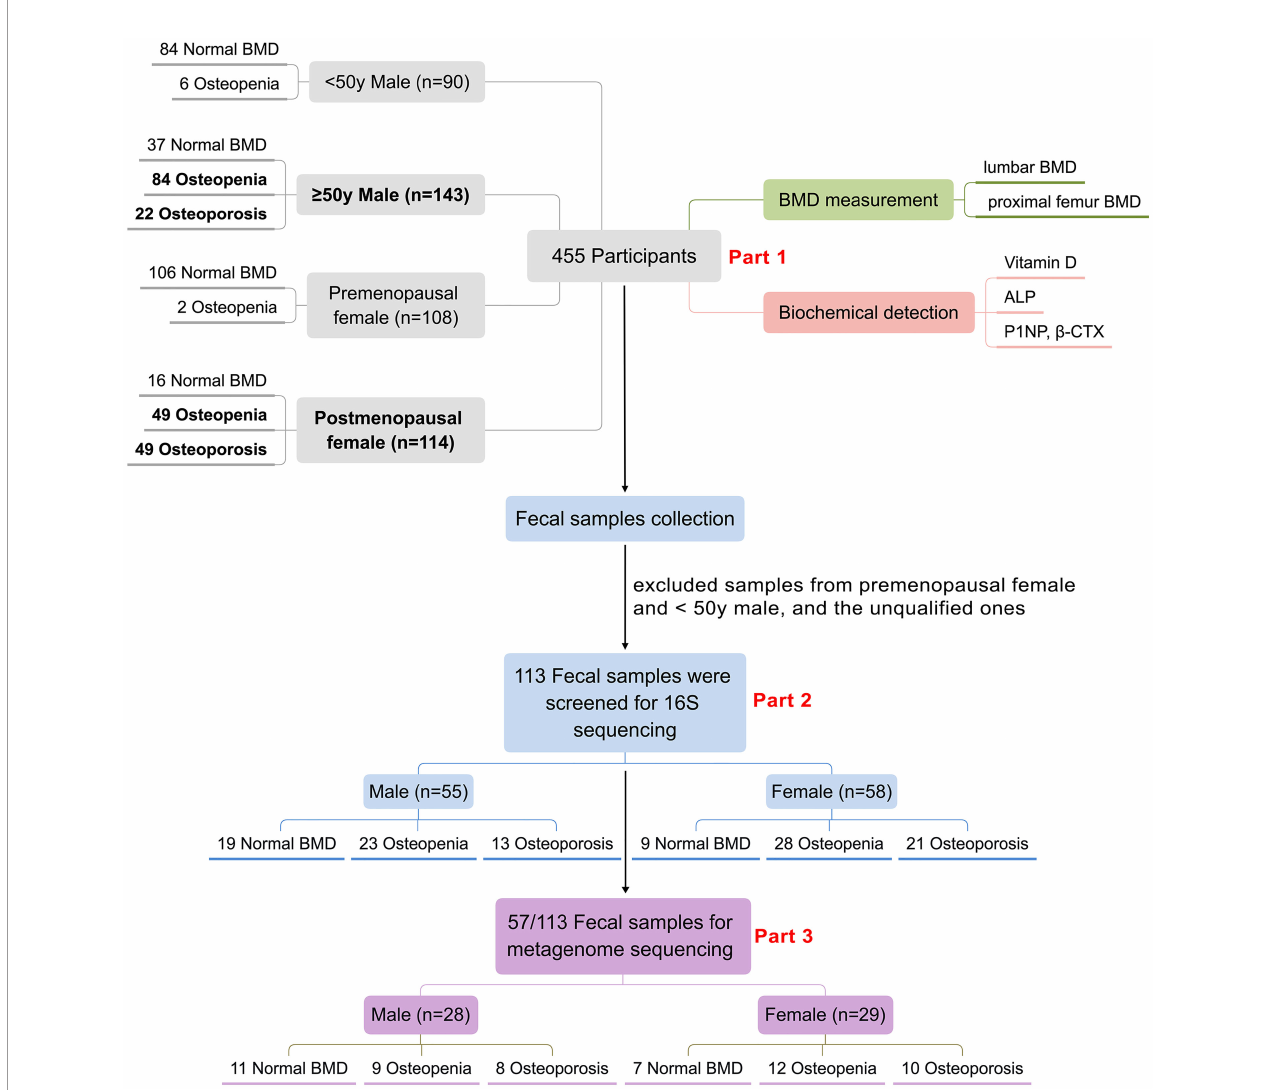
FIGURE 1 | Demographics of the study population. 455 participants were involved in this study, biochemical detection including serum vitamin D, ALP, P1NP and CTX as well as DXA-BMD measurement of the 455 participants were analyzed (Part 1). 113 participants including 55 males and 58 females were screened for GM 16S sequencing and analyses (Part 2), further 57 samples from the above 113 samples were selected for GM metagenome sequencing and analyses (Part